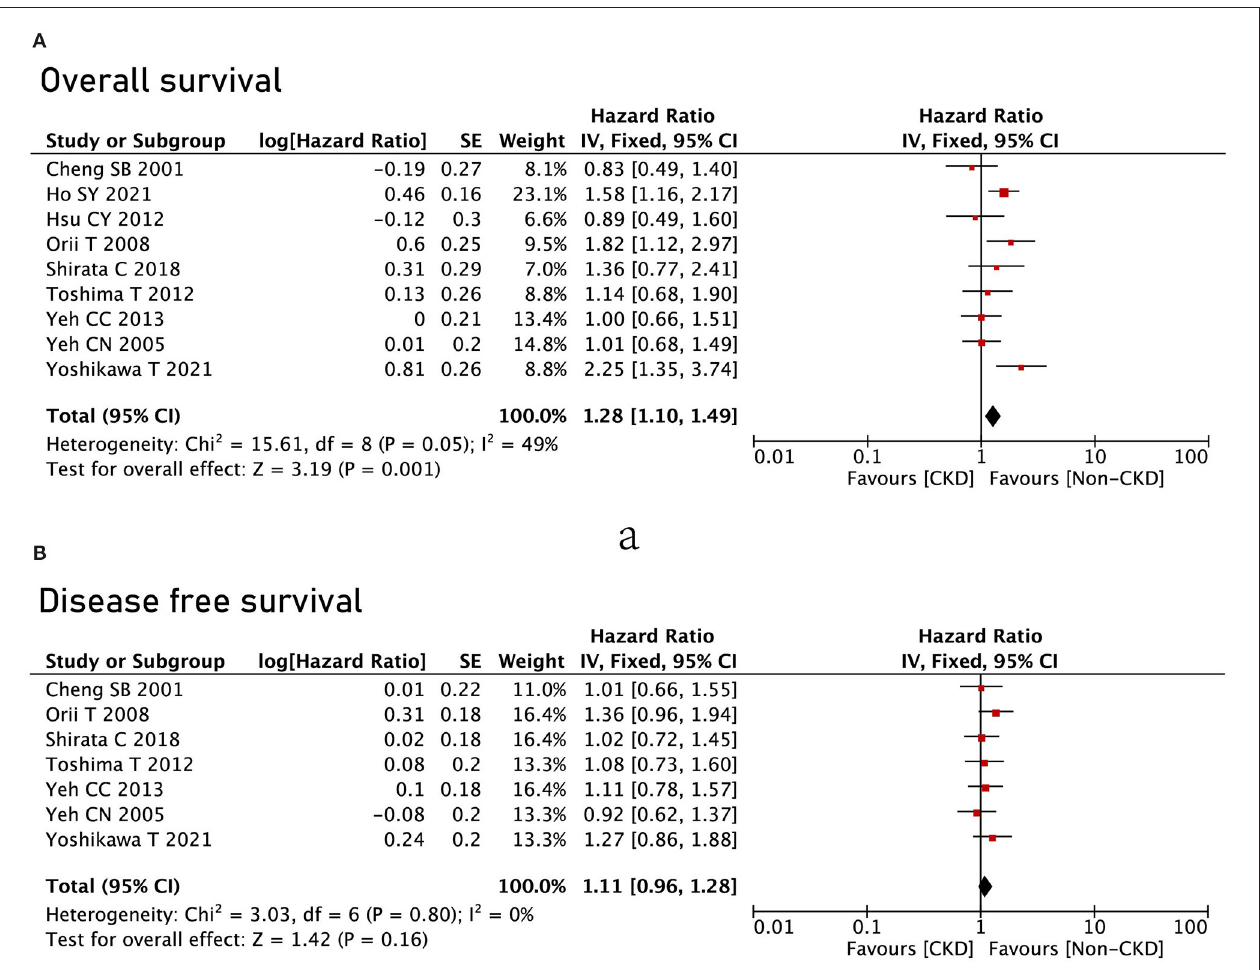
FIGURE 3 | Survival analysis between the CKD group and the non-CKD group. (A) Overall survival; (B) disease-free